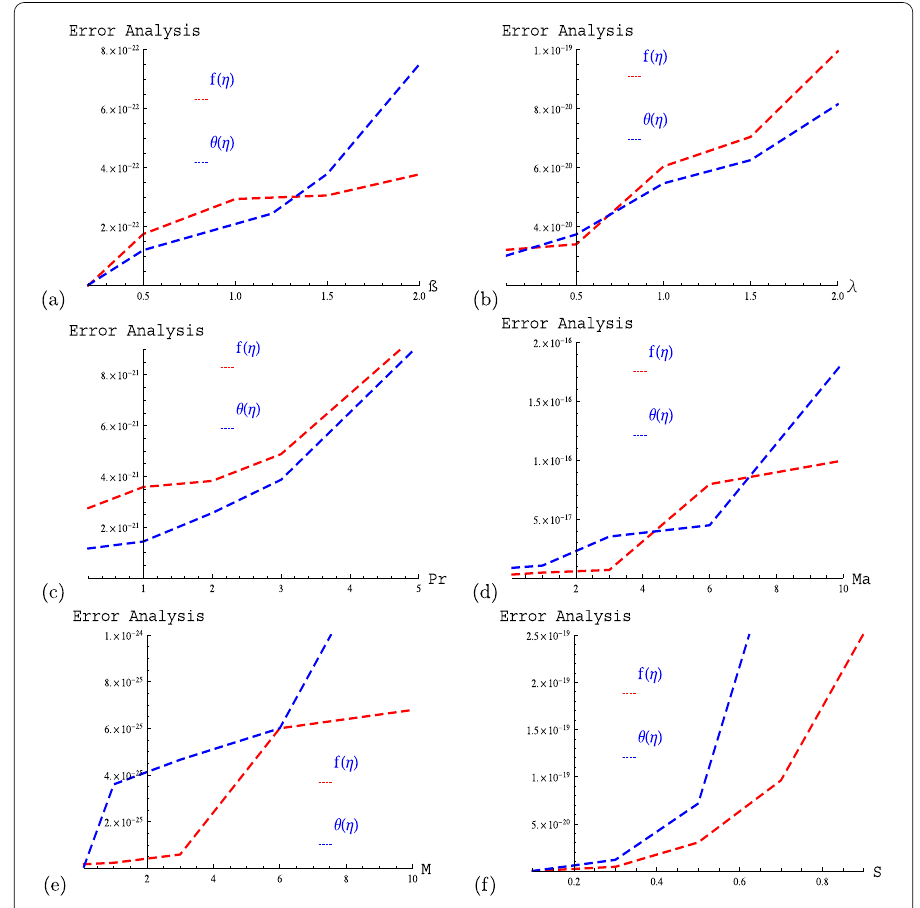
Figure 27 Error versus parameters range for velocities and temperature